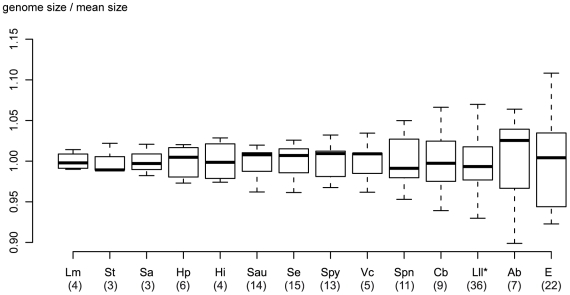
Comparison of chromosome size diversity within several bacterial species.For each species, the genome size distribution, summarized as a boxplot, is plotted according to the mean size. The species are ordered by increasing chromosome size diversity. Chromosomes sizes were obtained from sequence data (http://www.ncbi.nlm.nih.gov/genomes/genlist.cgi?taxid=2&type=1&name=Bacteria%20Complete%20Chromosomes). The number of chromosomes sequenced is indicated in brackets. Abbreviations: Lm, L. monocytogenes; St, S. thermophilus; Sa, S. agalactiae; Hp, H. pylori; Hi, H. influenzae; Sau, S. aureus; Se, S. enterica; Spy, S. pyogenes; Vc, V. cholerae; Spn, S. pneumoniae; Cb, C. botulinum; Lll, L. lactis subsp. lactis; Ab, A. baumannii; Ec, E. coli.